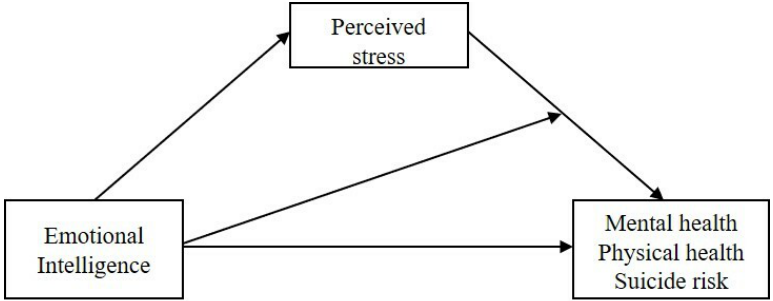
Figure 1. Proposed model of the relationships between emotional intelligence (EI), perceived stress and mental health, physical health, and suicide